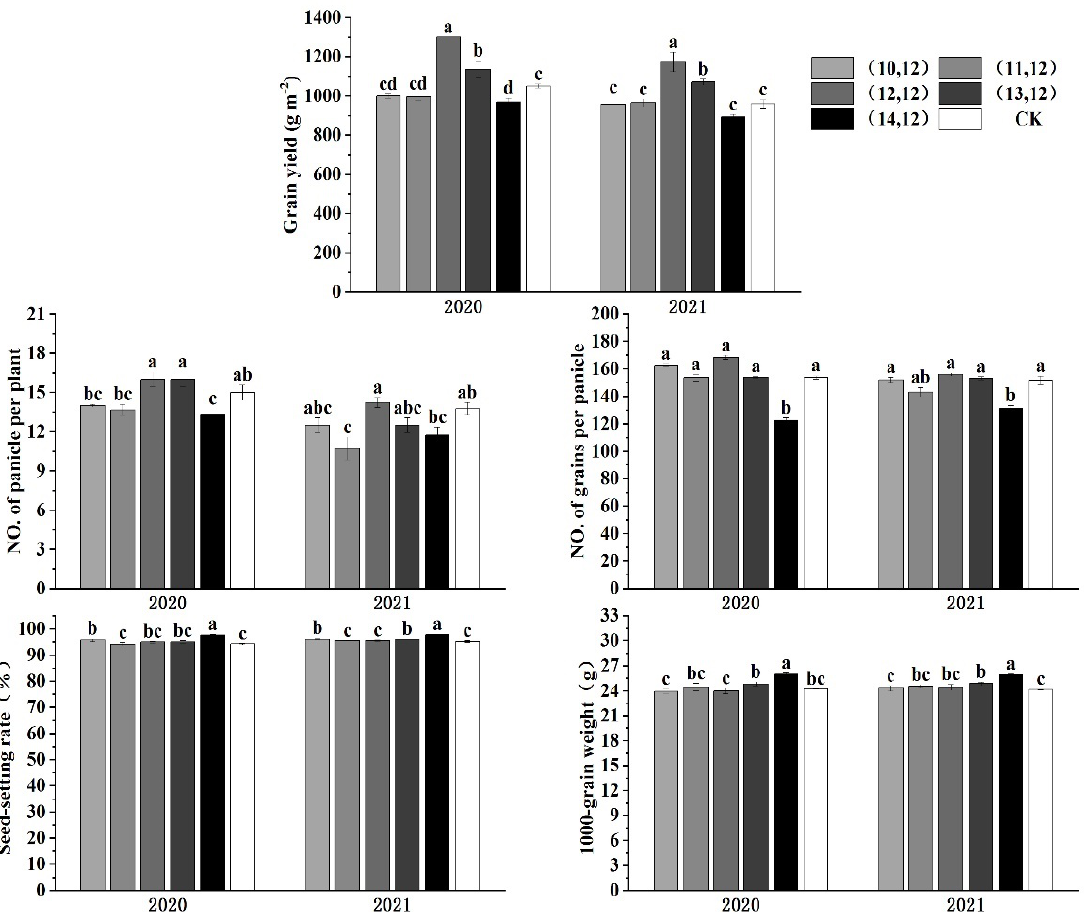
Figure 2. Effects of N and K application on rice yield and yield components at different leaf ages patterns in 2020 and 2021, with the results of the two-factor ANOVA. The (10, 12), etc., represent the patterns of different applications of N and K at the panicle stage; CK is the fertilization pattern of local farmers. Error bars indicate standard errors of three replicates. Different lowercase letters above the columns indicate significant differences ( p < 0.05) among different panicle fertilizer application patterns in the same year. Table 2. Effects of different N, K, and Y combined application during the panicle stage on rice yield and yield components in 2020 and 2021, with the results of the three-way ANOVA.